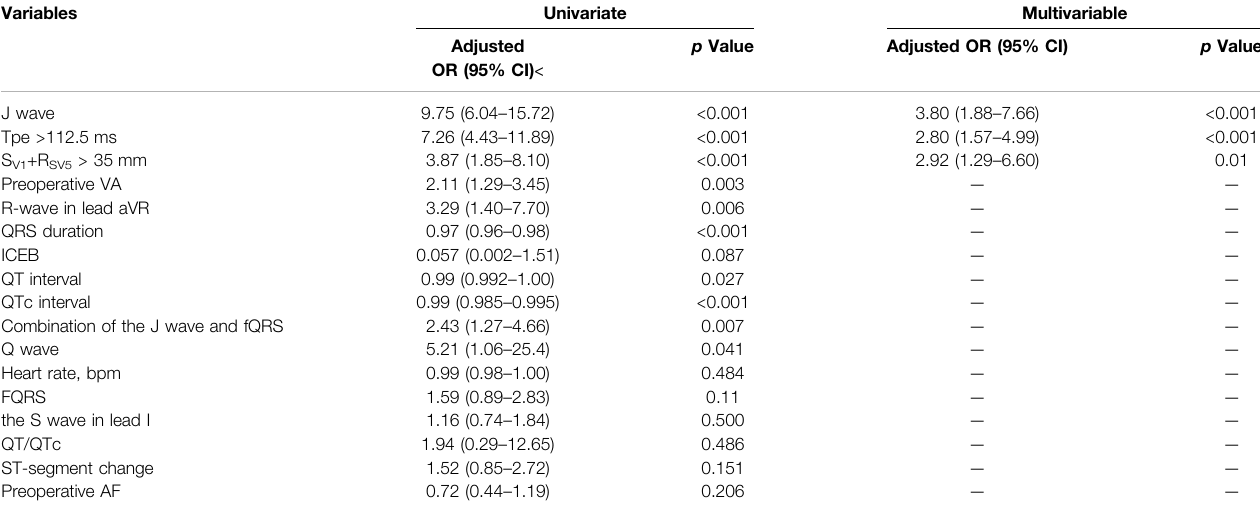
TABLE 3 | Analyses of independent electrocardiographic markers of POVA using logistic regression models.